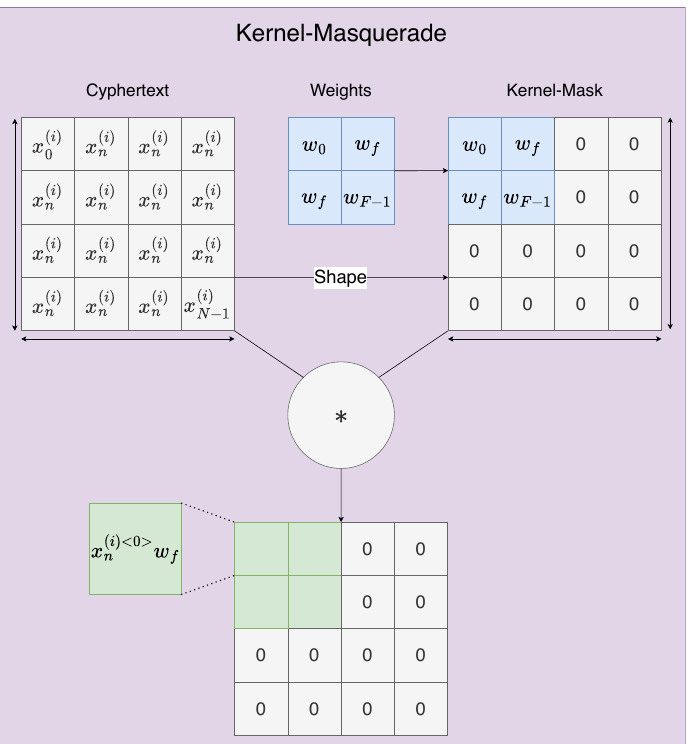
Figure 6. A mergedmask and kernel together to create a single sparse kernel which zeros undesired components in the cyphertexts polynomial of values using Hadmard products. Please see our documentation for closer detail [28]. Symbol ‘ ∗ ’ denotes element-wise